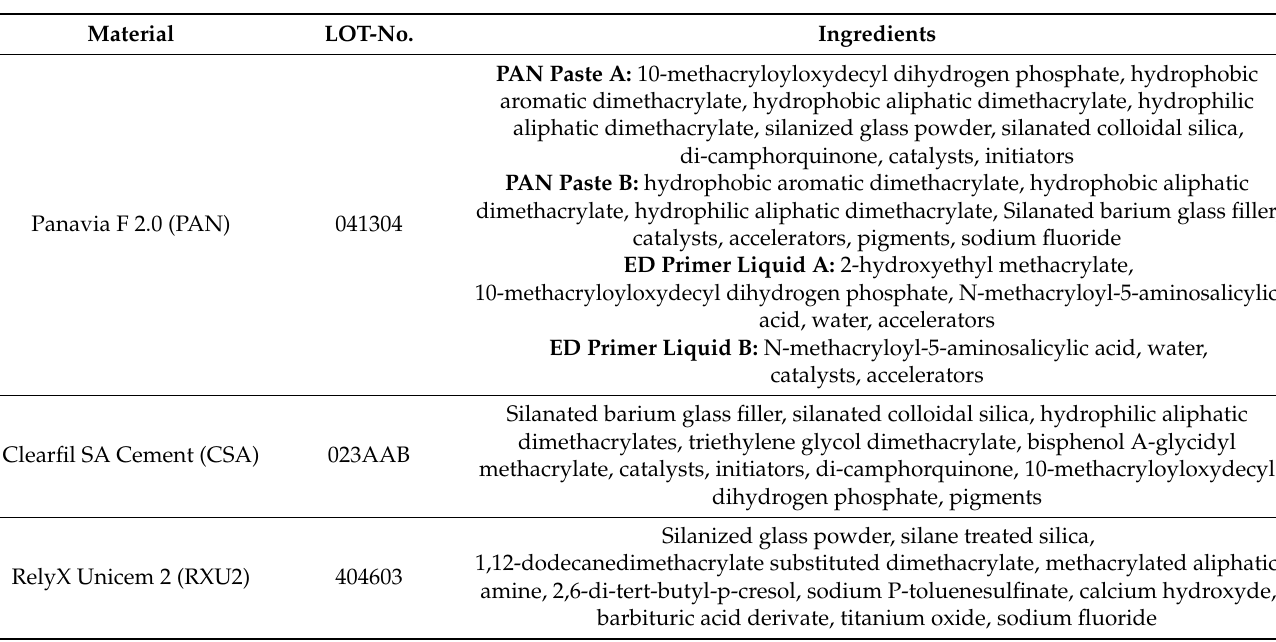
Table 1. Luting agents and ingredients according to the manufacturers. The order of ingredients does not represent the respective ingredient concentrations [19]. Material LOT-No.